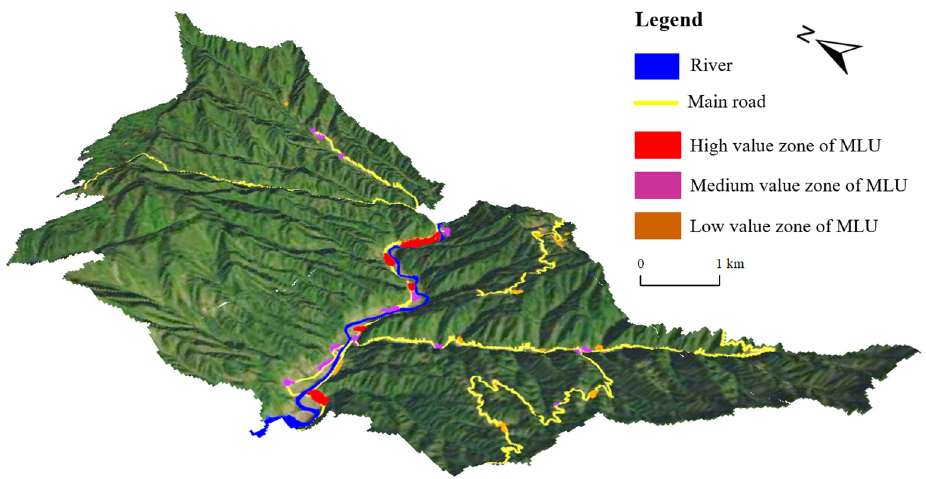
Figure 4. The coupling relationship between the horizontal spatial characteristics of MLUs in rural settlements and the natural environment in the study area in 2021. Table 7. Regression coefficient table of MLU levels and socioeconomic factors.